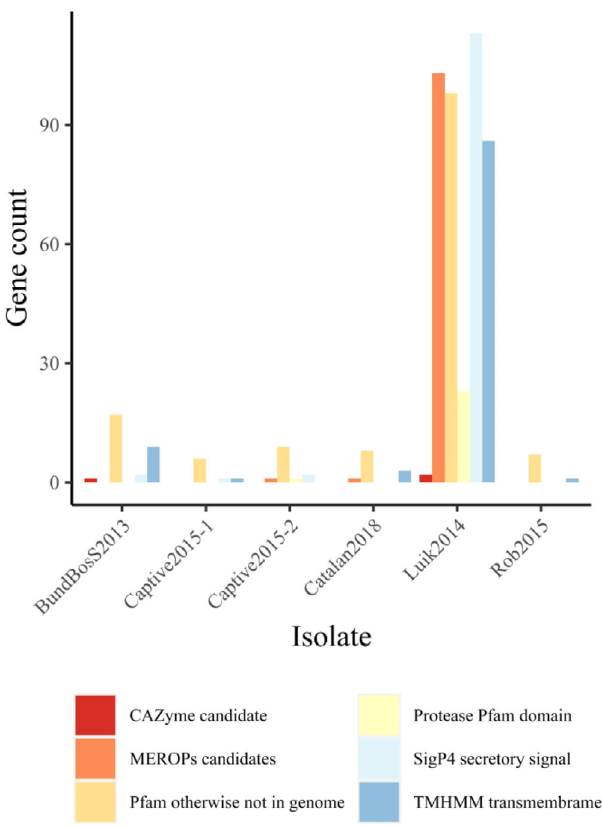
Fig. 4 Variation in genes identi fi ed as candidates for horizontal gene transfer. Comparison of number of horizontal gene transfer candidate genes, determined using phylogenetic techniques, and their annotations. Given that not all HGT candidates were annotated within one of these groups, and some maybe be included in more than one of these categories (e.g. a protease Pfam and a Pfam otherwise not present within the assembly), thus the total HGT candidate counts do not equal the sum of the depicted columns: BundBos2013 (total 43 candidates), Luik2014